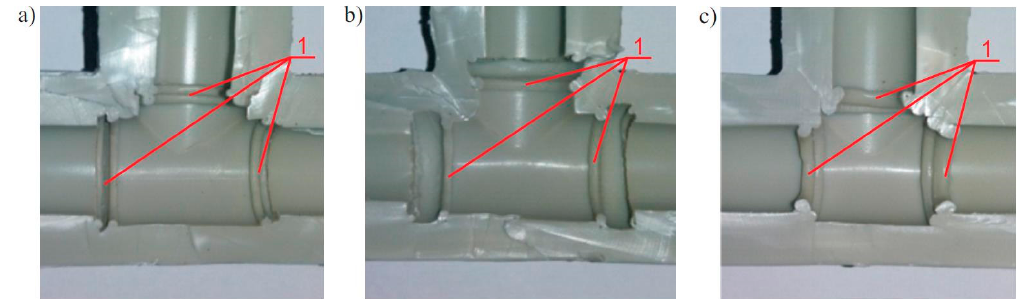
Figure 3. Three types of polypropylene T-junction with visible fashes resulting from the pressing of the welded elements to each other: ( a ) properly warmed up and properly pressed T-junction, ( b ) poorly warmed up and poorly pressed T-junction, ( c ) excessively warmed up and excessively pressed T-junction; 1: fash resulting from the pressing of the welded elements to each other.